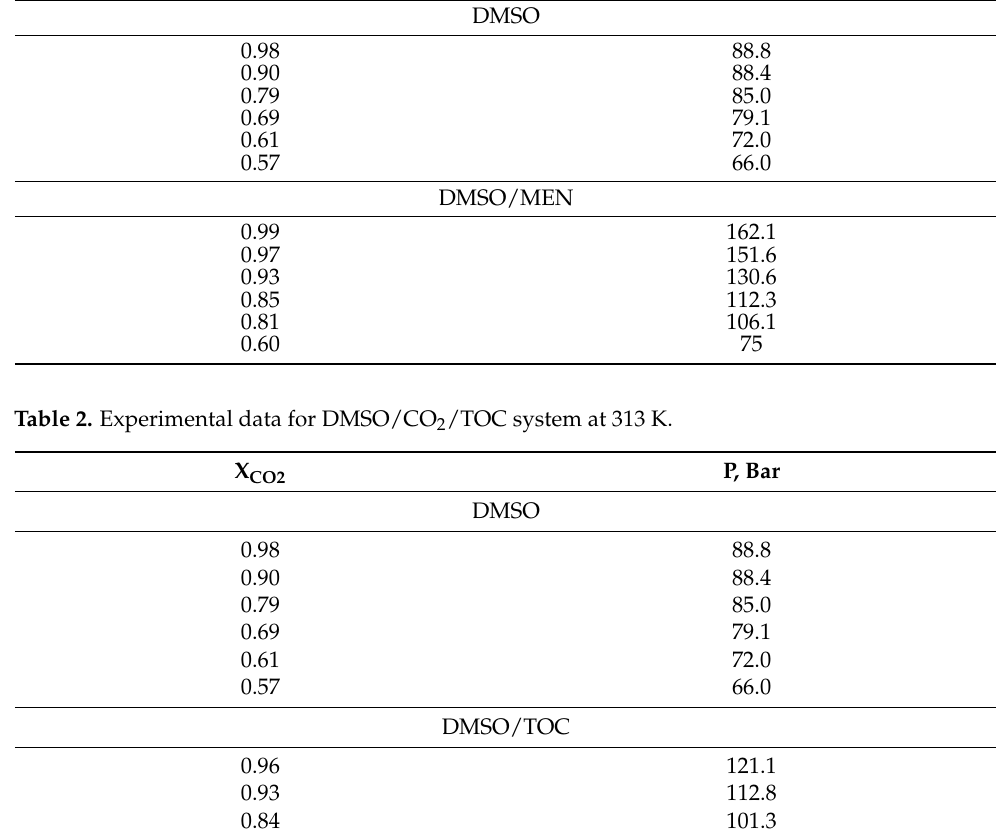
Table 1. Experimental data for DMSO/CO 2 /MEN system at 313 K.